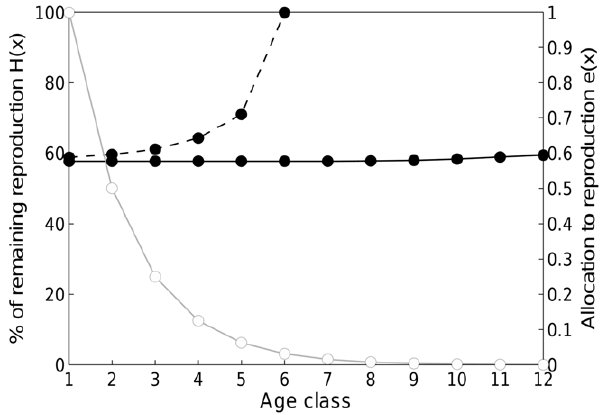
Figure 6. Importance of mutation accumulation vs. optimization in the model by Charlesworth [ 21 ] . Black circles indicate allocation to reproduction e(x) for a non-mutated phenotype (solid line) and for a phenotype loaded with mutations (dashed line). White circles represent the level of remaining reproduction left to an individual at that age (which captures selection pressure against deleterious mutations). Without mutations the optimal allocation patterns is approximately constant. With mutation accumulation, strong differences in allocation strategy between mutated and non-mutated phenotype appear at ages when the percentage of lifetime reproduction left to an organism has fallen below 5%. (Calculations based on Table 2 by Charlesworth [21]).